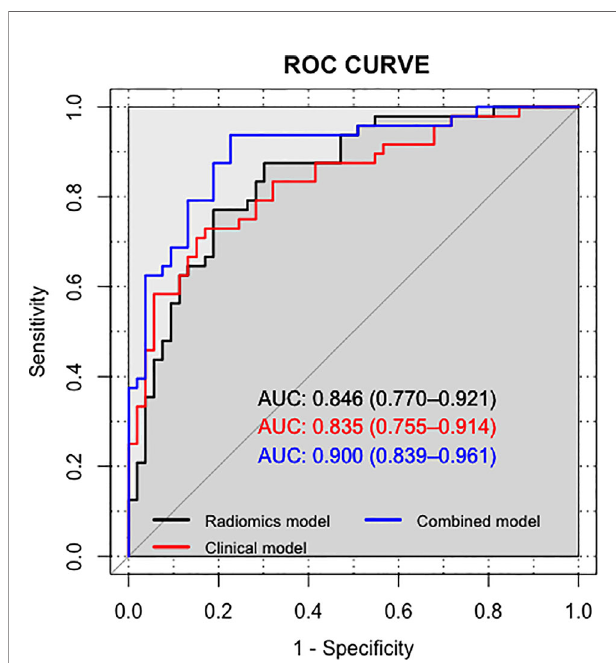
FIGURE 7 | Comparison of ROC curves for differentiation of the three models for predicting